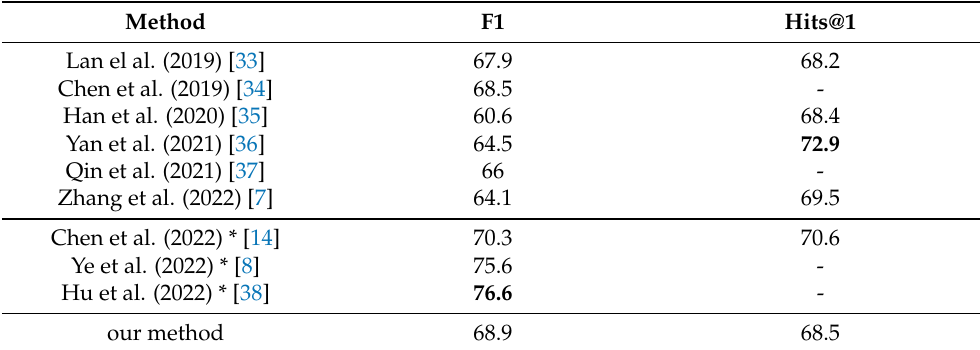
Table 1. Experimental results for comparison with baselines.